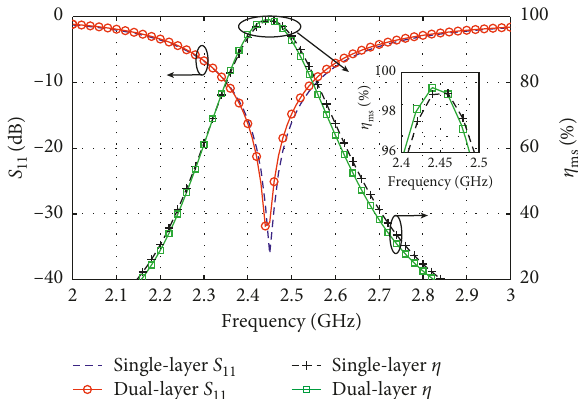
Figure 2: Simulated unit cell S